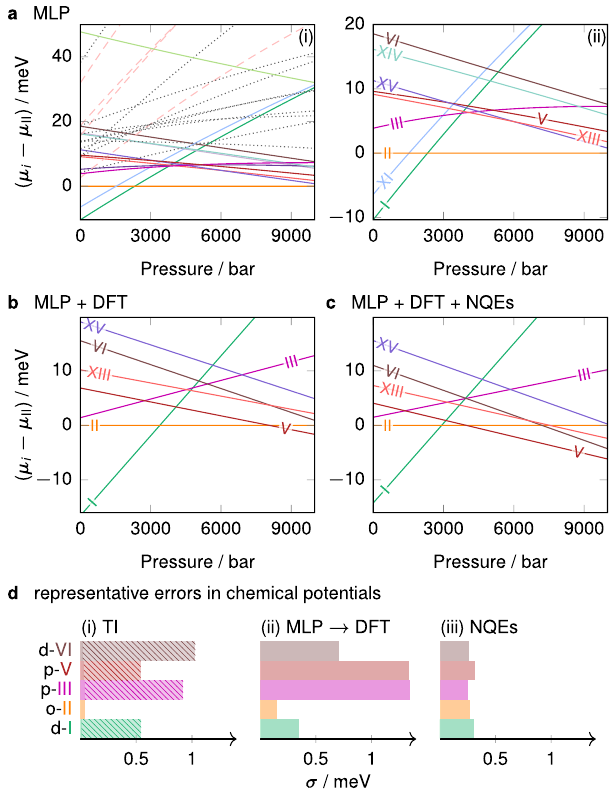
Fig. 2 Computed chemical potentials and error analysis. Per-molecule chemical potentials for the phases (meta)stable at 225 K, shown relative to the chemical potential of ice II. The MLP results are in a . In subpanel (i), solid lines show experimentally known bulk phases, dashed lines show various known low-density structures, and dotted lines show other hypothetical phases. Subpanel (ii) shows the same data, but only for the known experimental phases, as labelled. b Shows the chemical potentials at the level of the revPBE0-D3 DFT for classical systems, and c shows DFT results with NQE corrections. d Illustrates representative standard deviations for selected proton-disordered ( ‘ d ’ ), partially proton-disordered ( ‘ p ’ ) and proton-ordered ( ‘ o ’ ) phases. Contributions are split into those arising from (i) the thermodynamic integration to the classical system described by the MLP, with the contribution from proton disorder shown as a lighter hatched area; (ii) the MLP to the revPBE0-D3 correction term; and (iii) the term accounting for